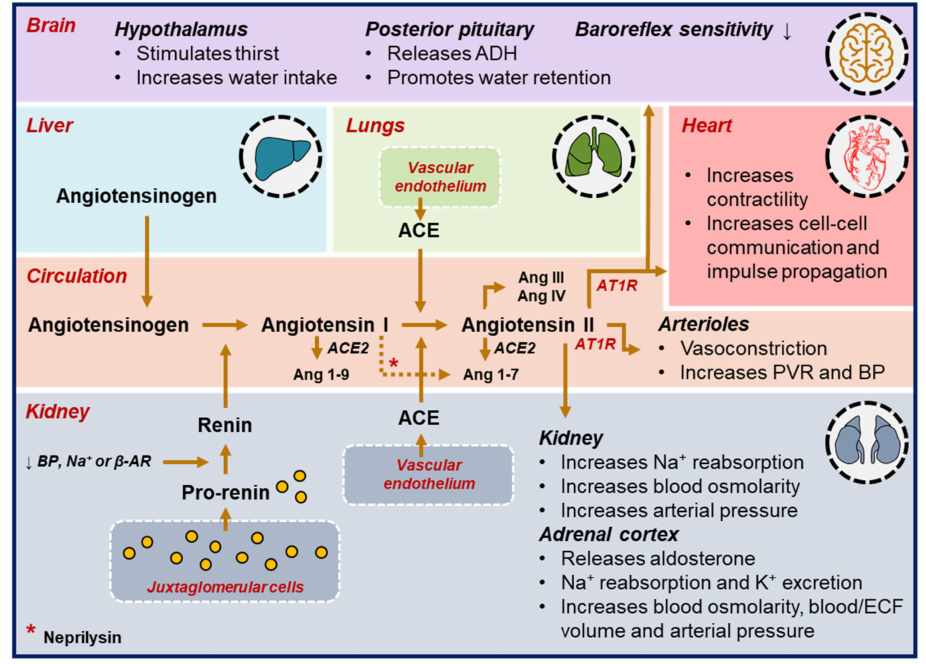
Figure 1. The renin-angiotensin-aldosterone activation cascade. Several stimuli including a de- crease in blood pressure (BP), reduced sodium (Na + ) levels, or activation of the autonomic nervous system promote the conversion of pro-renin into renin, which then cleaves angiotensinogen into angiotensin I. Subsequently, angiotensin I is converted into angiotensin II and binds to angiotensin receptors in brain, heart, kidney, adrenal cortex and arterioles to retain water, reabsorb sodium and initiate vasoconstriction. (ACE = angiotensin-converting enzyme; ADH = antidiuretic hormone; Ang = angiotensin; AT1R = angiotensin receptor type 1; ECF = extracellular fluid; K + = potassium; Na + = sodium; PVR = peripheral vascular resistance; β -AR = β -adrenergic receptor